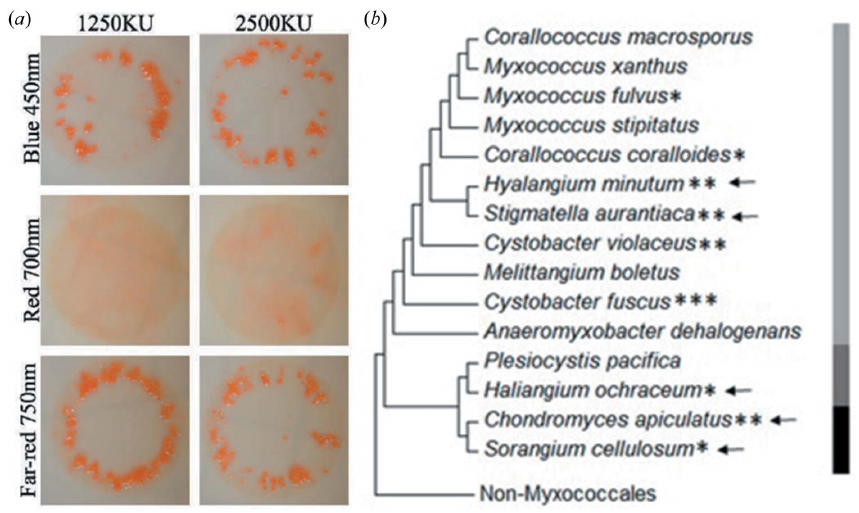
Figure 2 Fruiting-body formation in S. aurantiaca , and phylogenetic tree of Myxococcales. ( a ) Comparison of fruiting-body formation with (from top to bottom) blue (450 nm), red (700 nm) and far-red (750 nm) light illumination. Cell concentration is expressed in Klett Units (KU). ( b ) Phylogenetic comparison of Myxococcales indicating strains coding for BphPs with an asterisk (the number of asterisks indicates the number of BphPs) and photoactive yellow protein (PYP) with arrows. The side bar highlights three different suborders of Myxococcales: Cystobacterineae (light gray), Nanocystineae (dark gray) and Sorangineae (black). BphPs and PYPs are found in select species within all three suborders of Myxobacteria; the number and type of photoreceptors present varies between